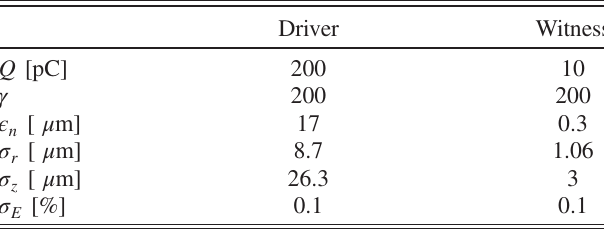
TABLE V. Working point n p ¼ 4 × 10 16 cm − 3